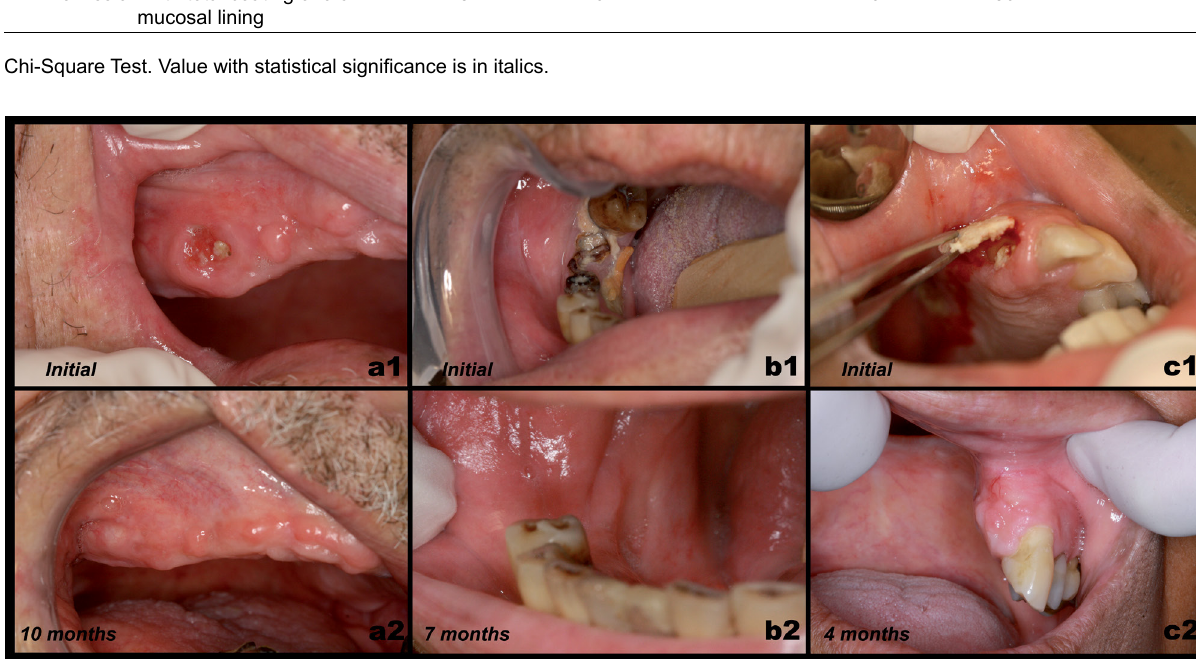
Figure 4- Osteoradionecrosis of the jaw (ORNJ) remission with total coating of oral mucosal lining in patients treated with LLLT and aPDT. ORNJ stage I in posterior maxilla in remission after 10 months (a). ORNJ stage II in posterior mandible in remission after 7 months (b). ORNJ stage II in anterior maxilla in remission after 4 months (c). Both patients were followed-up for two years and so far there was no recurrence of the